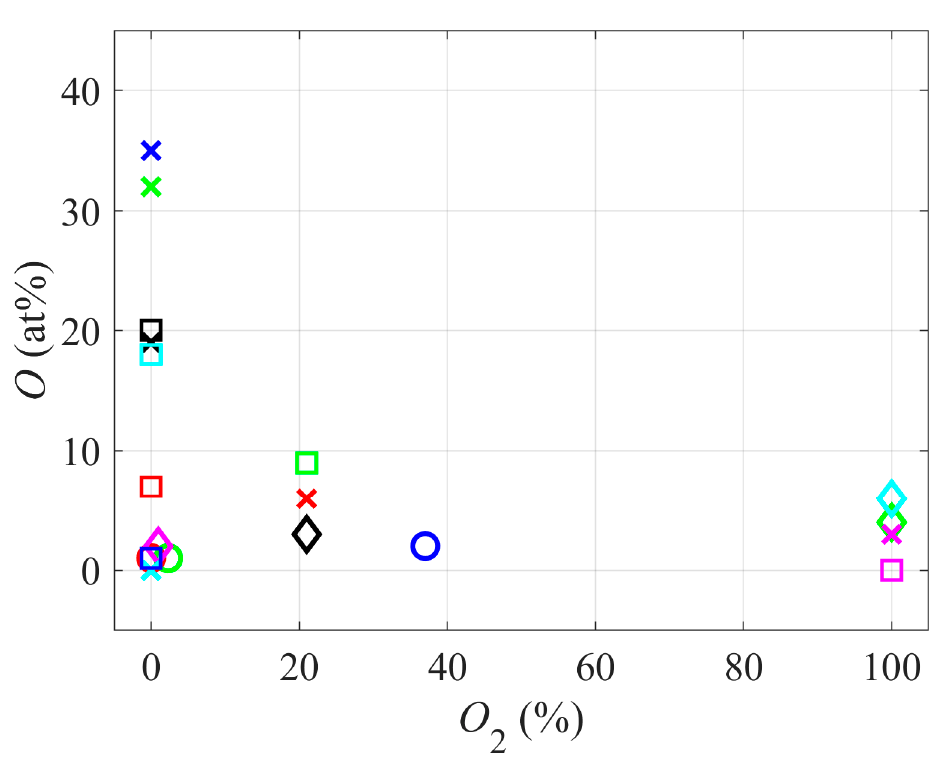
Figure 2. The concentration of oxygen in the surface film versus the concentration of oxygen in gaseous plasma.